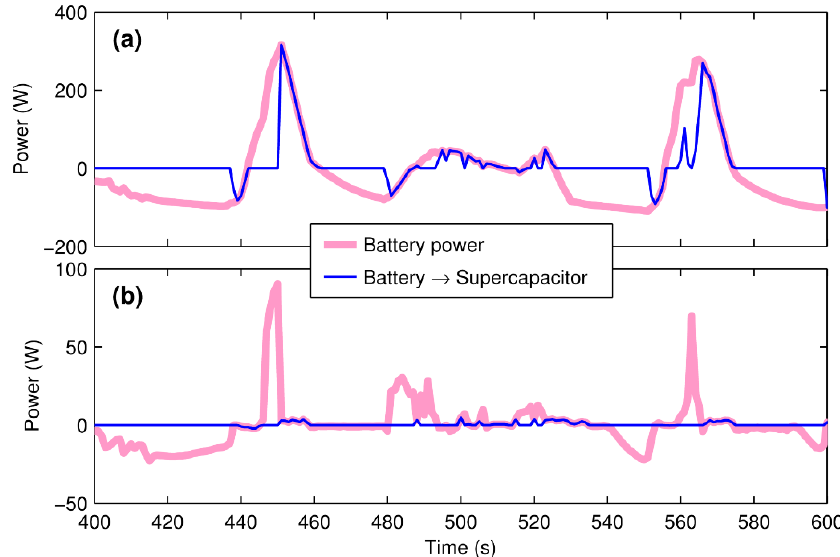
Figure 15. Experimental battery power and its part exchanged with the supercapacitor for ( a ) S1; and ( b )